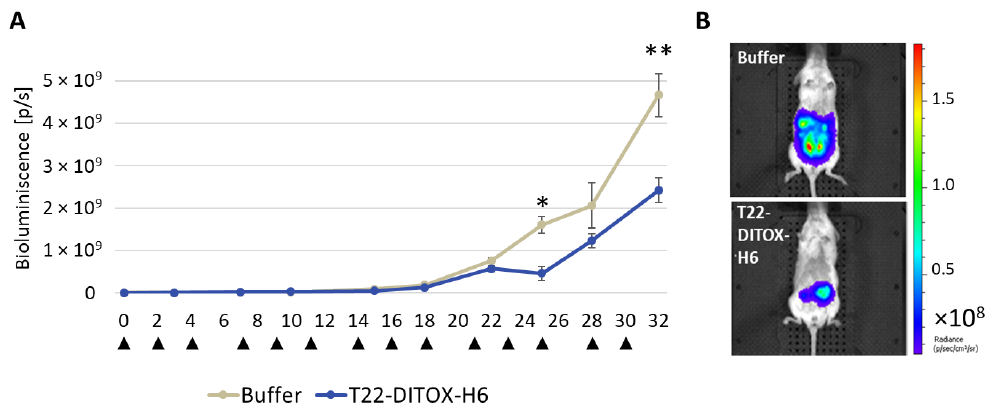
Figure 6. T22-DITOX-H6 repeated dosage reduces whole-body bioluminescence emission in an orthotopic CXCR4 + AN3CA EC model. ( A ) Total bioluminescence intensity (BLI) registered over time in mice treated with buffer or T22-DITOX-H6 ( n = 9 animals per group). Data are reported as mean ± SEM. Asterisks indicate significant differences in emitted BLI between the compared groups using the Mann–Whitney U test (* p < 0.05; ** p < 0.01). Arrows indicate treatment administration. ( B ) Representative images of the control and nanotoxin-treated mice as registered by IVIS Spectrum at day